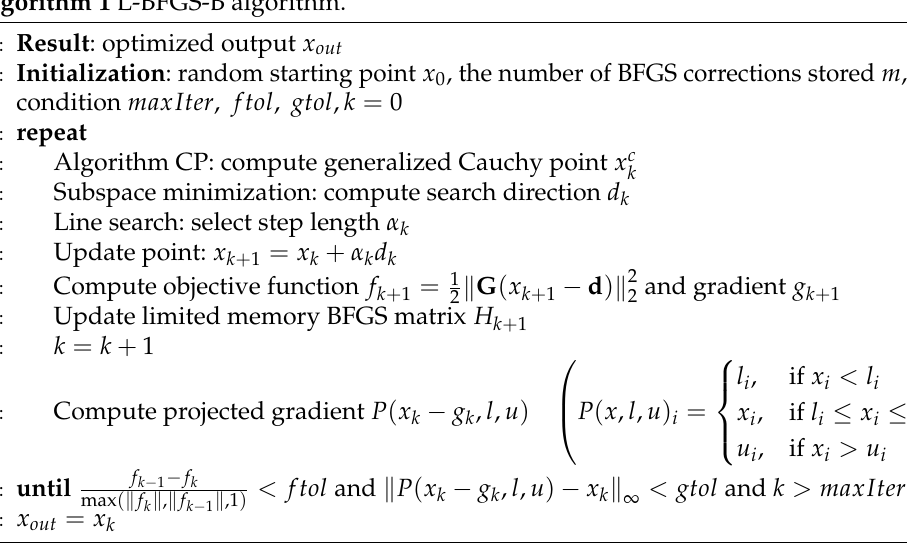
Algorithm 1 L-BFGS-B algorithm.